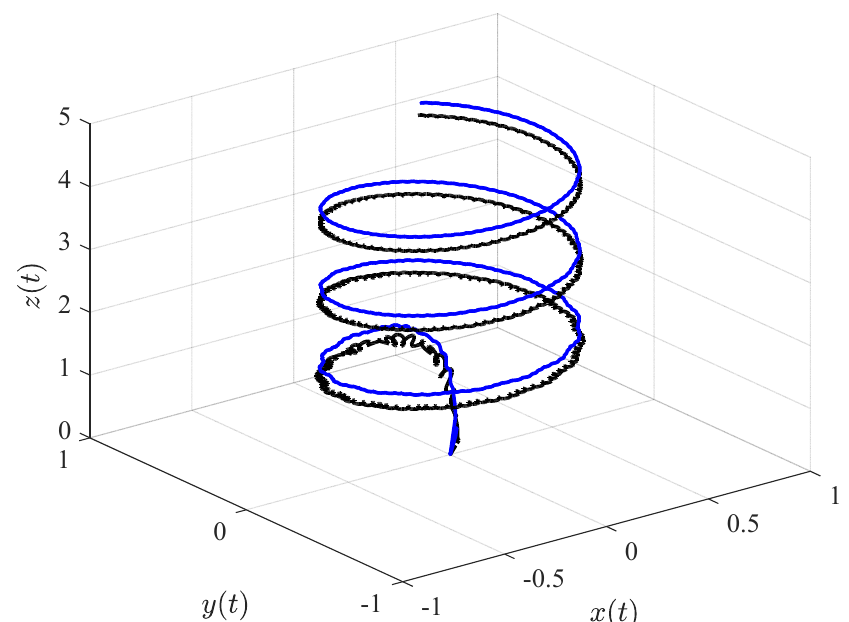
Figure 13. Circular trajectory, showing the trajectories of the quadrotor (solid blue line) and its payload (dashed black line).